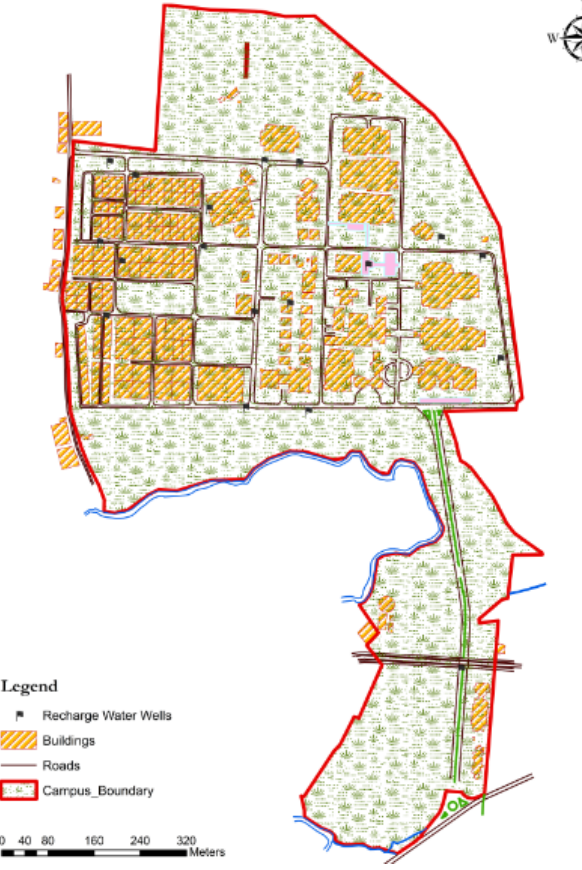
Figure 10. Water accumulation points where recharge wells are proposed. Table 2. Soil classification of boreholes.